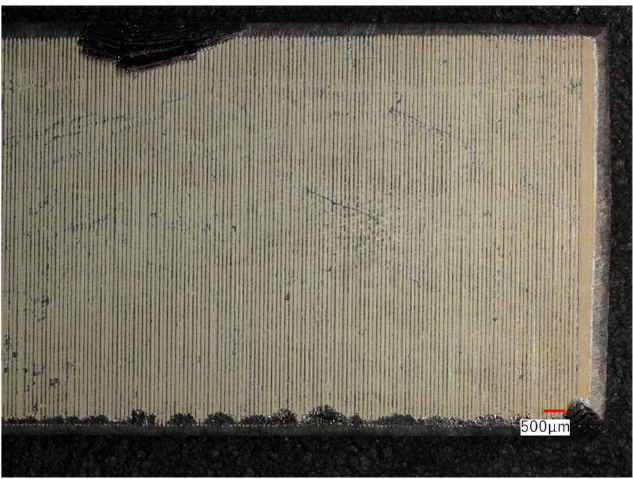
Figure 2. Screen printing of a line-segment array onto the VGS surface.